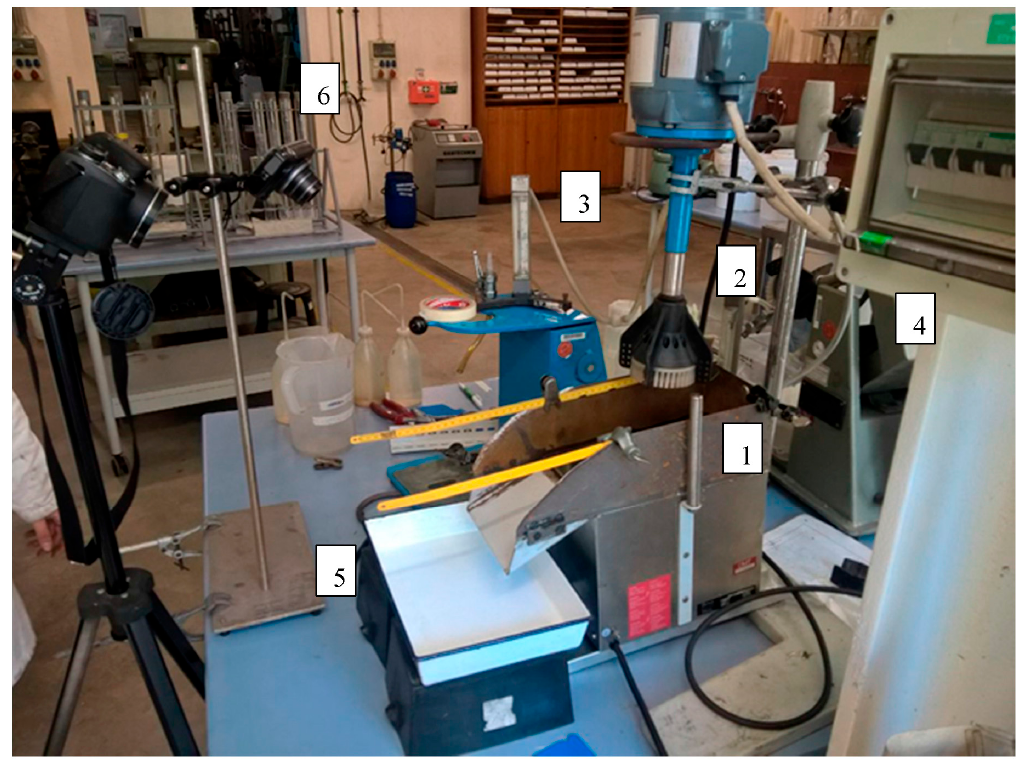
Figure 2. A photo of the re-designed flotation cell (1. Refurbished ultrasonic bath used as a